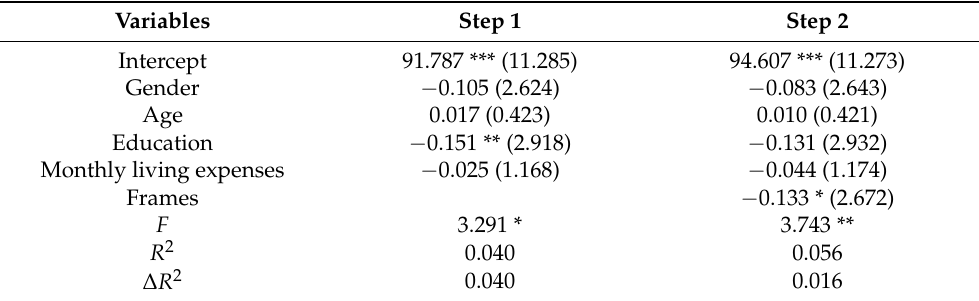
Table 3. Hierarchical regression analysis of the willingness to participate in the ILBRS.